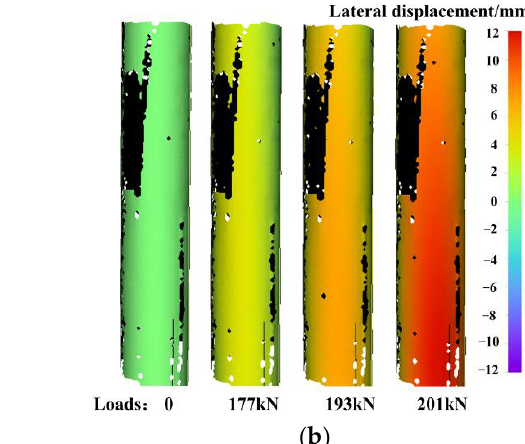
Figure 21. Full-circle lateral displacement field of the circular column under axial load.